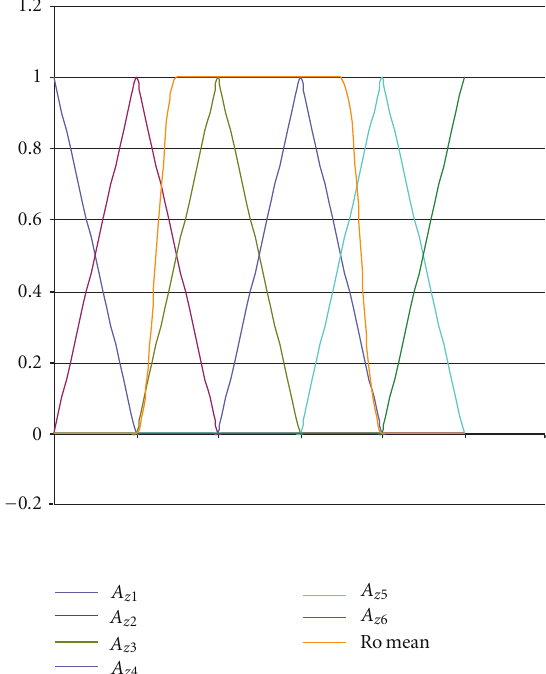
Table 3: Parameters for fuzzy sets associated to the linguistic expressions.